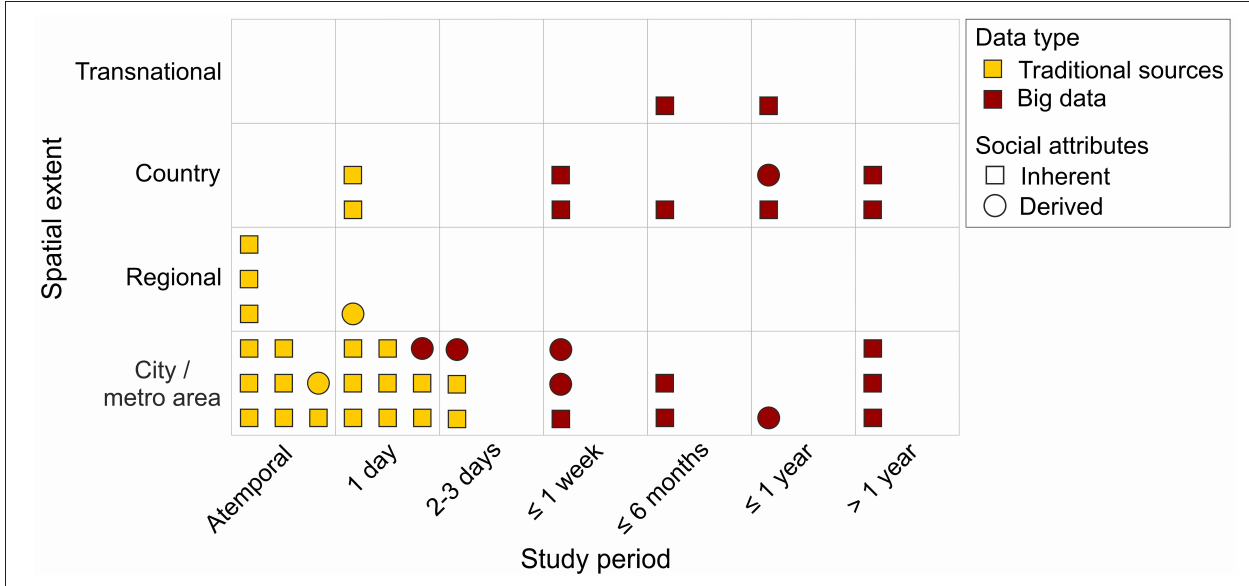
FIGURE 13 | Distribution of activity space segregation studies by spatial and temporal dimension ( n = 44). Studies are further divided by whether social attributes for segregation analysis are inherent in data or derived from a complementary data source.